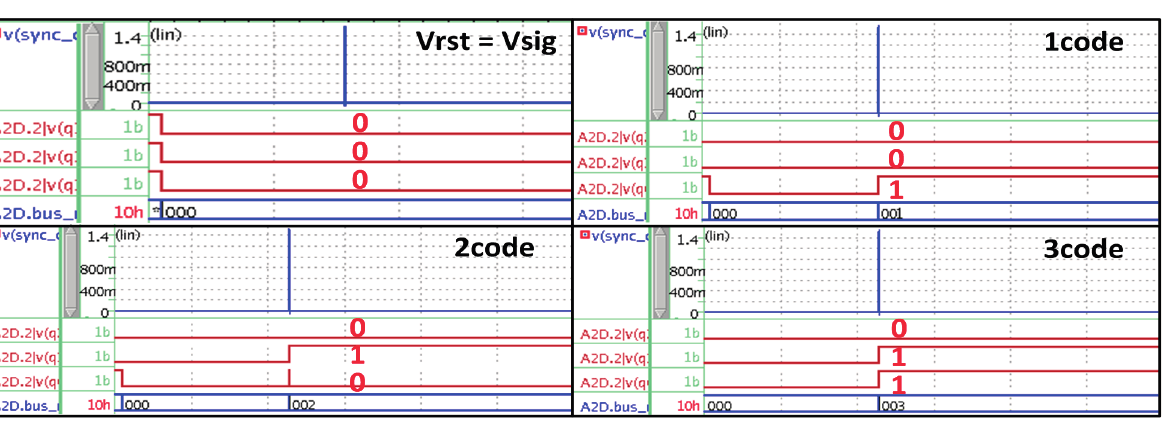
Figure 8. SPICE results for the novel digital CDS with the main clock of 200 MHz.